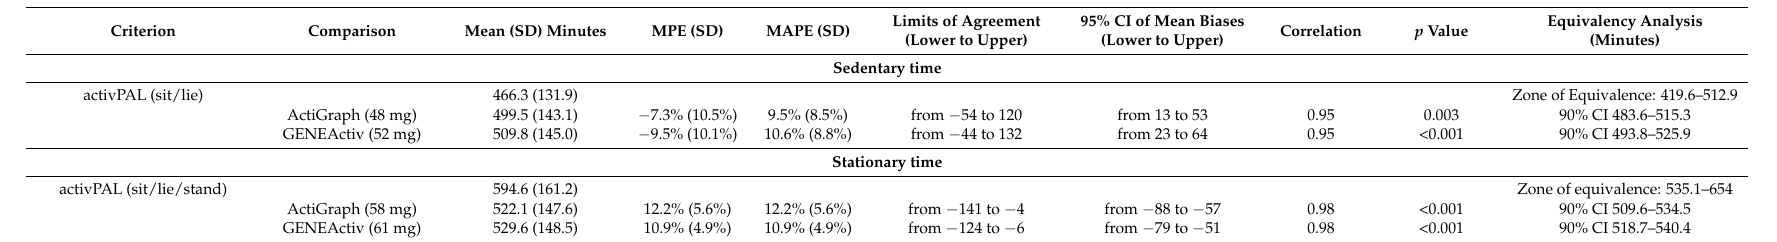
MPE = mean percentage error; MAPE = mean absolute percentage error; CI = confidence